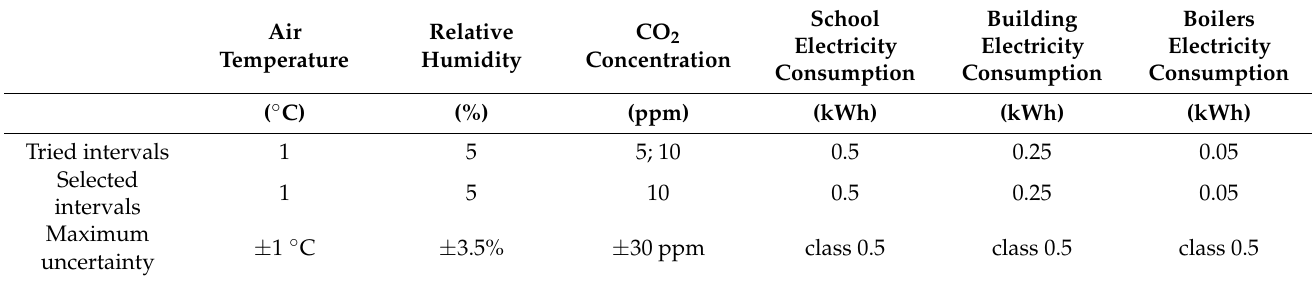
Table 1. Intervals considered in the histogram generation, both tried and finally used. Additional information on the maximum uncertainty of the measurement